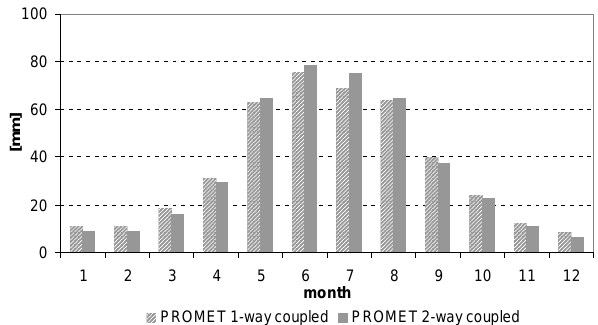
Figure 10: Monthly mean evapotranspiration in the Upper Danube catchment of 1-way and 2- Fig. 10. Monthly mean evapotranspiration in the Upper Danube way coupled PROMET simulations (1996-1999). catchment of 1-way and 2-way coupled PROMET simulations The change of evapotranspiration in the fully coupled PROMET/MM5 simulations highly depends on the simulated soil moisture. In the Upper-Danube catchment the wilting point is hardly ever reached, and evapotranspiration can increase in summer due to higher air temperatures without being affected by limited soil moisture.